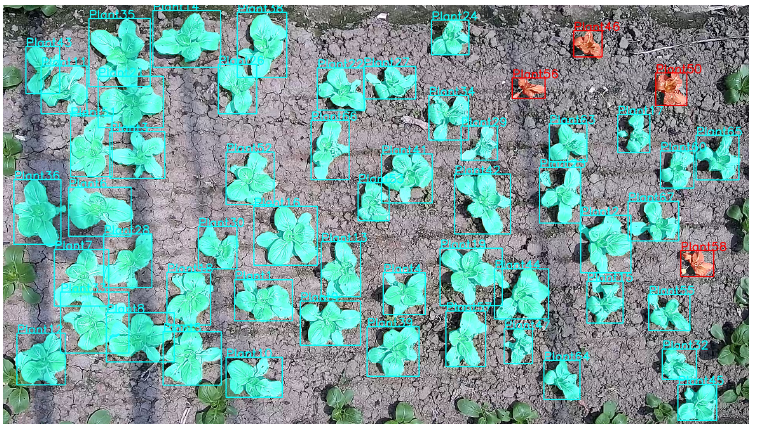
Figure 10. Visual results of abnormal plant detection considering the 2-day phenotypic changes. Cyan means normal leafy greens and red means abnormal leafy